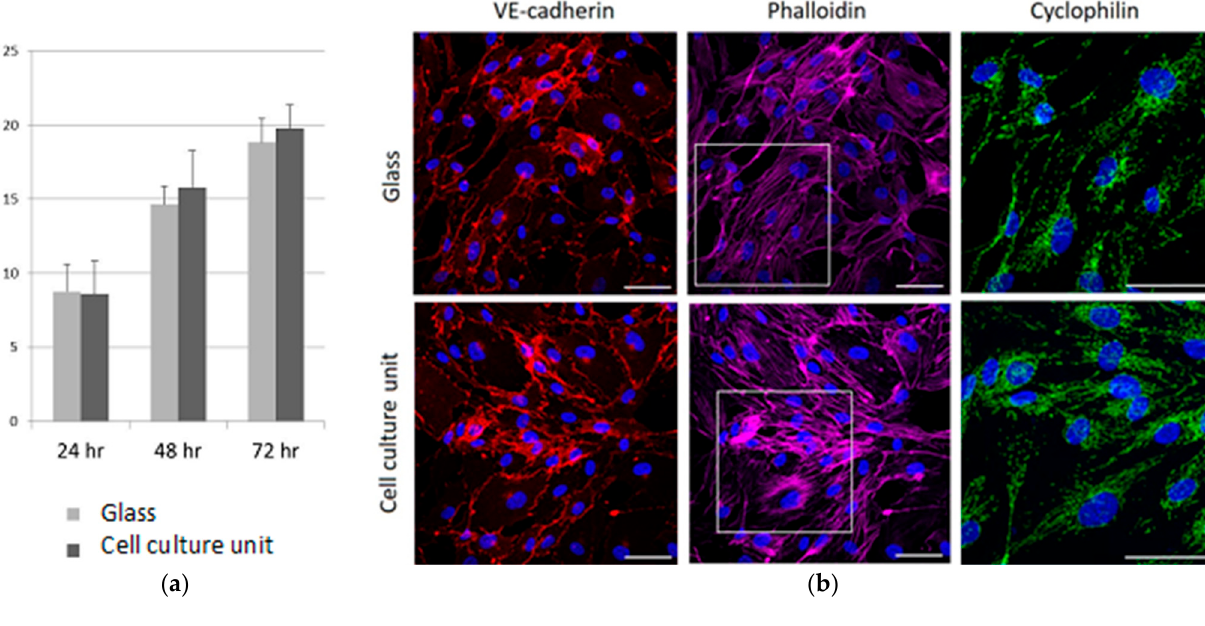
Figure 4. HUVEC were seeded via microfluidic control platform on cell culture unit or on glass coverslips as control. ( a ) The cells were counted using an automated cell counter. Data are the means ± standard deviation of five independent experiments in duplicate. ( b ) HUVEC were cultured on cell culture unit and on glass coverslips for 72 h. The cells were fixed and observed by confocal microscopy after phalloidin, Ve-cadherin, cyclophilin F, and DAPI staining. White square is zoomed-in cyclophilin staining image. Scale bar: 50 μ m.